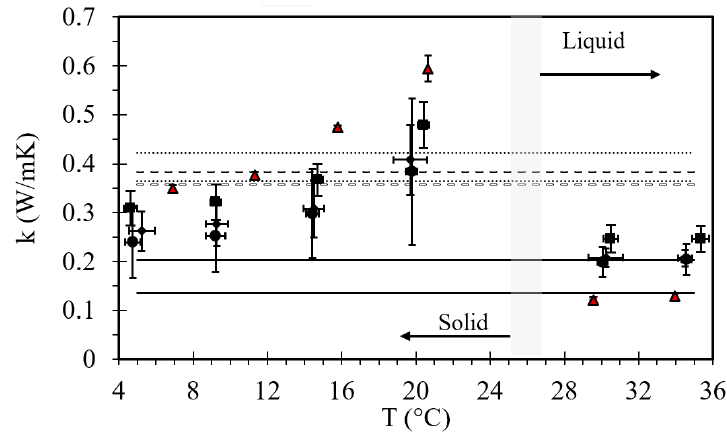
Figure 11. Pinus radiata wood impregnated with octadecane thermal conductivity (longitudinal: rhombus; tangential: square and radial: circle) of the unimpregnated wood (longitudinal: solid line; tangential: dashed line and radial: dotted line), and of octadecane (red triangle).